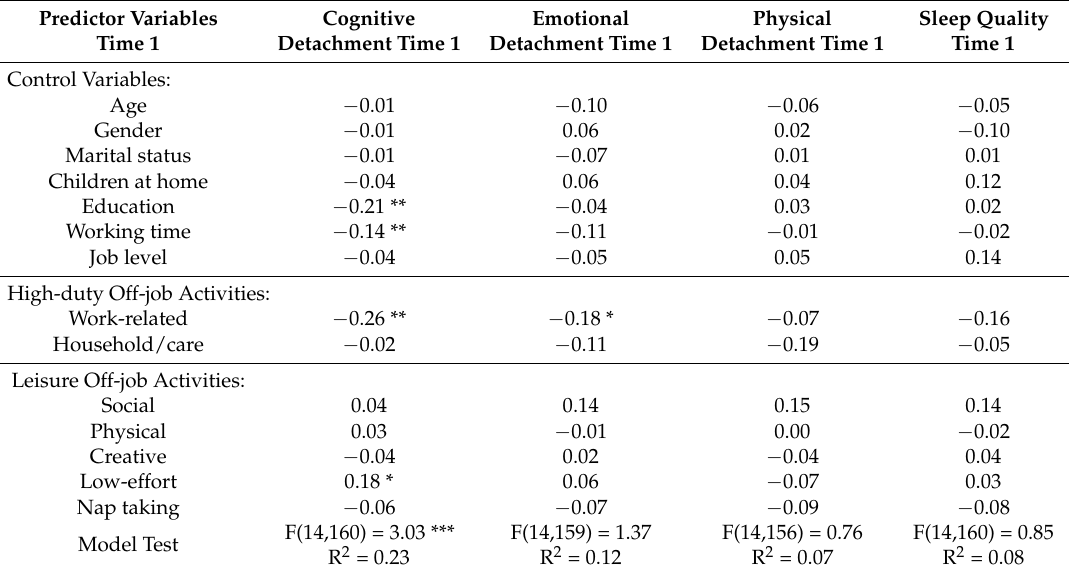
Table 2. Hierarchical regression analyses: Cross-sectional results ( n =